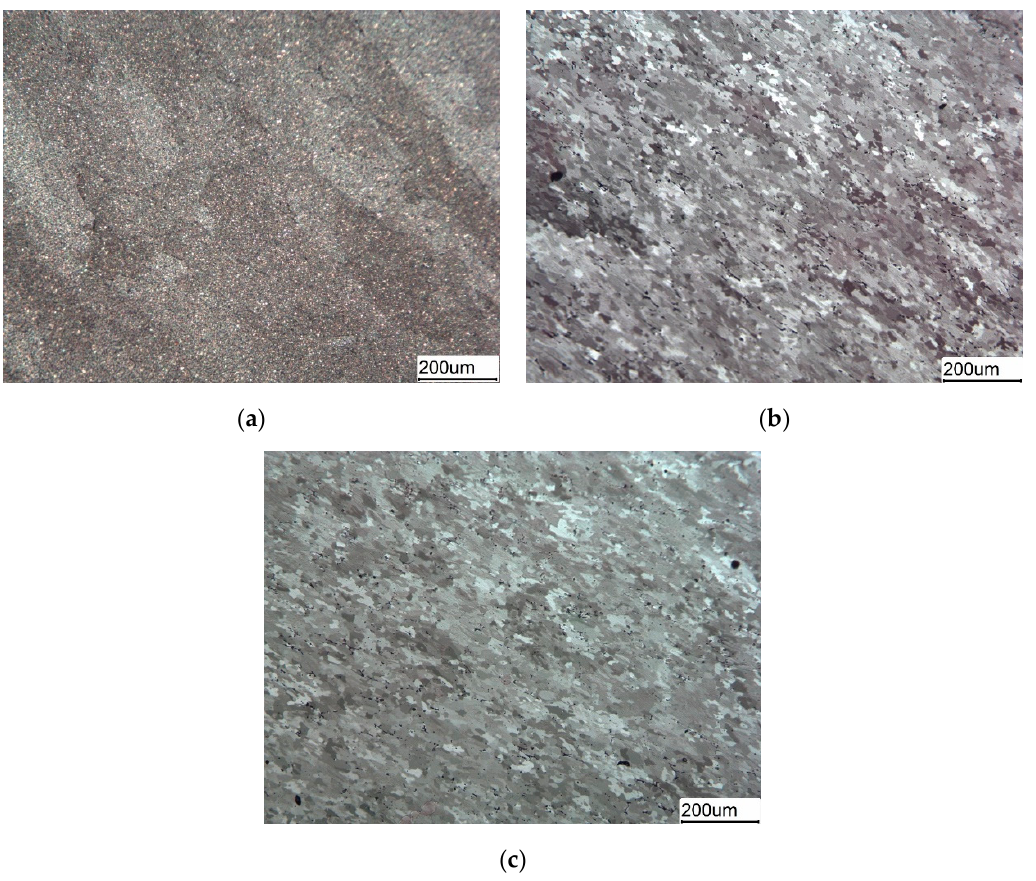
Figure 2. Simulation results of the effective strains produced from the deformed samples by using a set of ( a ) closed dies (hot forge); and ( b ) open dies (cold forge).